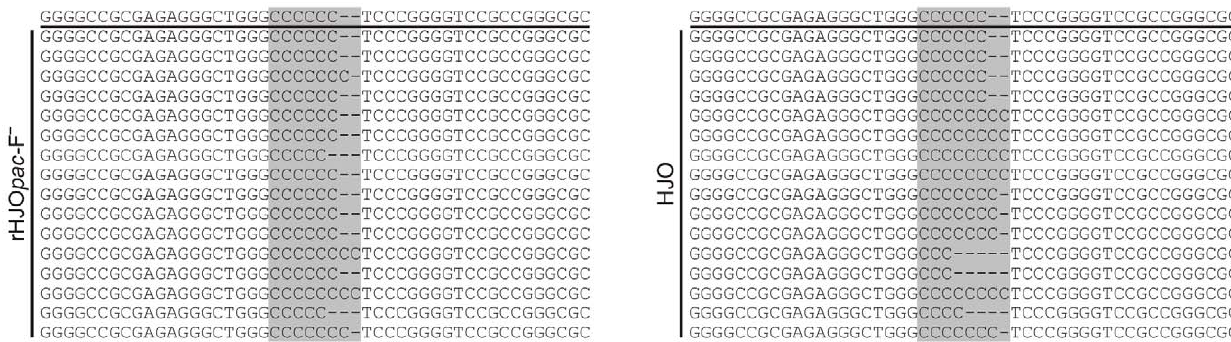
Figure 4. Sequence analysis after mini-F vector release from the genomic termini. Sequence analysis of 16 cloned PCR fragments that were generated by PCR amplification of the terminal genomic junction of rHJO pac -F - or wild-type HJO DNA. The derived sequences were aligned to the sequence of the terminal transition of the original pHJO clone (first line). The GC tracts directly at the junction are highlighted in gray.